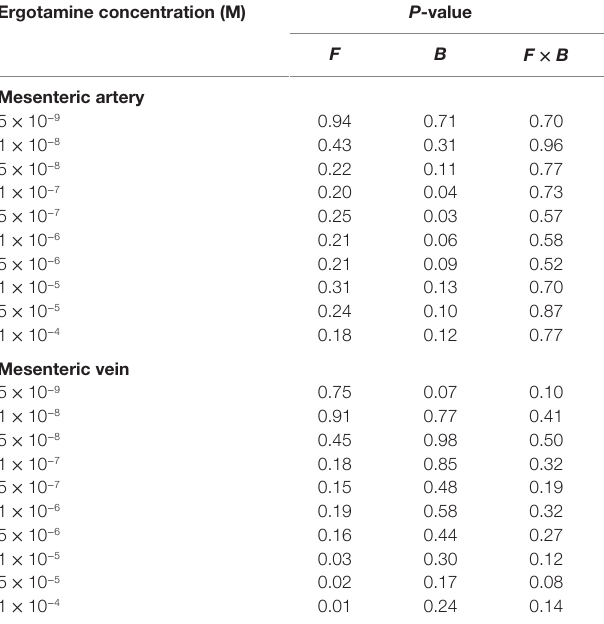
TaBle 4 | The analysis of variance and P -values of main effect of formononetin ( F ), biochanin a ( B ), and the interaction of formononetin and biochanin a ( F × B ) for pretreatments with tall fescue seed extract (eXT): 1 × 10 − 6 M (eXT); combinations of 1 × 10 − 6 M eXT and F , eXT and B , or 1 × 10 − 6 M eXT + B + F on every ergotamine